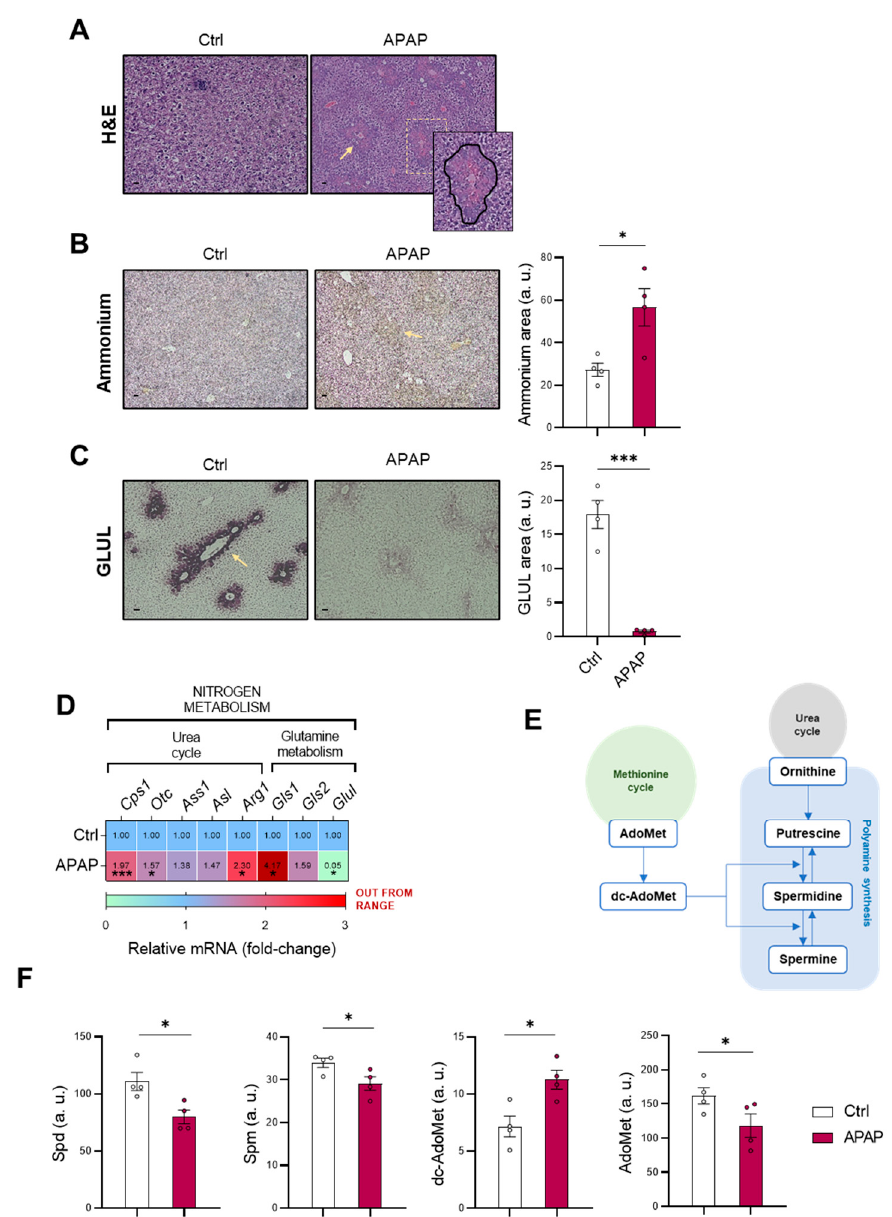
Figure 1. Ammonia homeostasis, methionine cycle and polyamine synthesis are altered in DILI. ( A ) Hepatic hematoxylin and eosin (H&E) staining (zoom-in); representative micrographs and respective quantification of ( B ) ammonia and ( C ) glutamine synthetase (GLUL) staining (highlighted with yellow arrows); ( D ) relative mRNA expression of the urea cycle and glutamine metabolism genes and ( F ) determination of spermidine (Spd), spermine (Spm), decarboxy-S-adenosylmethionine (dc-AdoMet) and S-adenosylmethionine (AdoMet) in liver from mice treated with 360 mg/kg acetaminophen (APAP) compared to healthy controls. ( E ) Schematic representation of interconnection among the methionine and urea cycles and polyamine synthesis. Scale bar corresponds to 50 μ m. * p < 0.05 and *** p < 0.001 are shown.